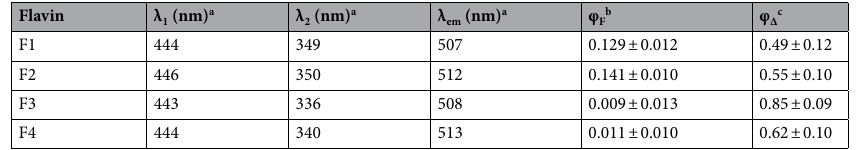
Table 1. Photophysical properties of flavins F1-4 . λ n = S 0 → S n absorption band, λ em = emission wavelength, φ F = fluorescence quantum yield, φ Δ = singlet oxygen quantum yield. a measured in DMSO. b calculated using riboflavin as the reference (ϕ F = 0.226 ± 0.001 in DMSO). c calculated using Ru(bpy) 32+ as the reference (ϕ Δ = 0.57 ± 0.06 in